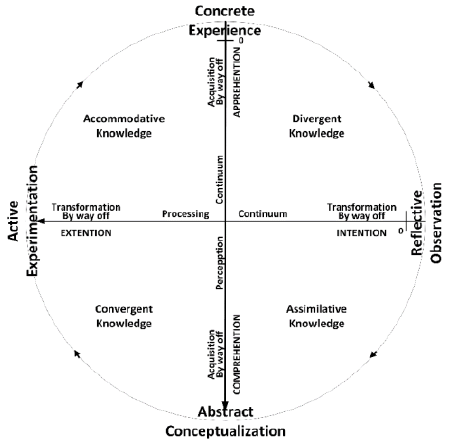
Fig. 2. Graphic reference for the Kolb model, adapted from Kolb [41].